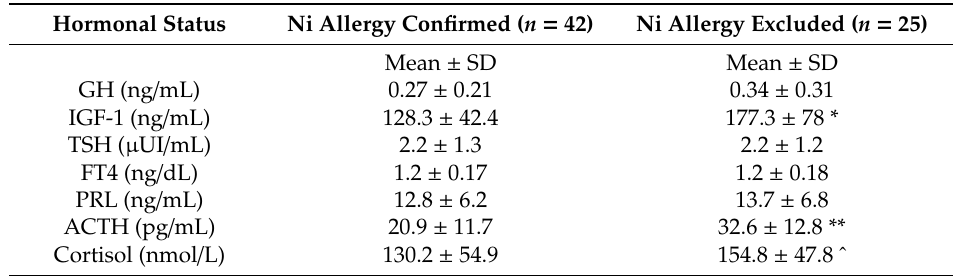
Table 2. Pituitary hormone levels in subjects with and without Ni allergy. Abbreviations: SD, Standard Deviation; Ni, Nickel; GH, Growth Hormone; IGF-1, Insulin-like Growth Factor 1; TSH, thyroid stimulating hormone; FT4, Free Thyroxine; PRL, Prolactin; ACTH, Adrenocorticotropic hormone. * p < 0.05. ** p < 0.01. ˆ p < 0.1.